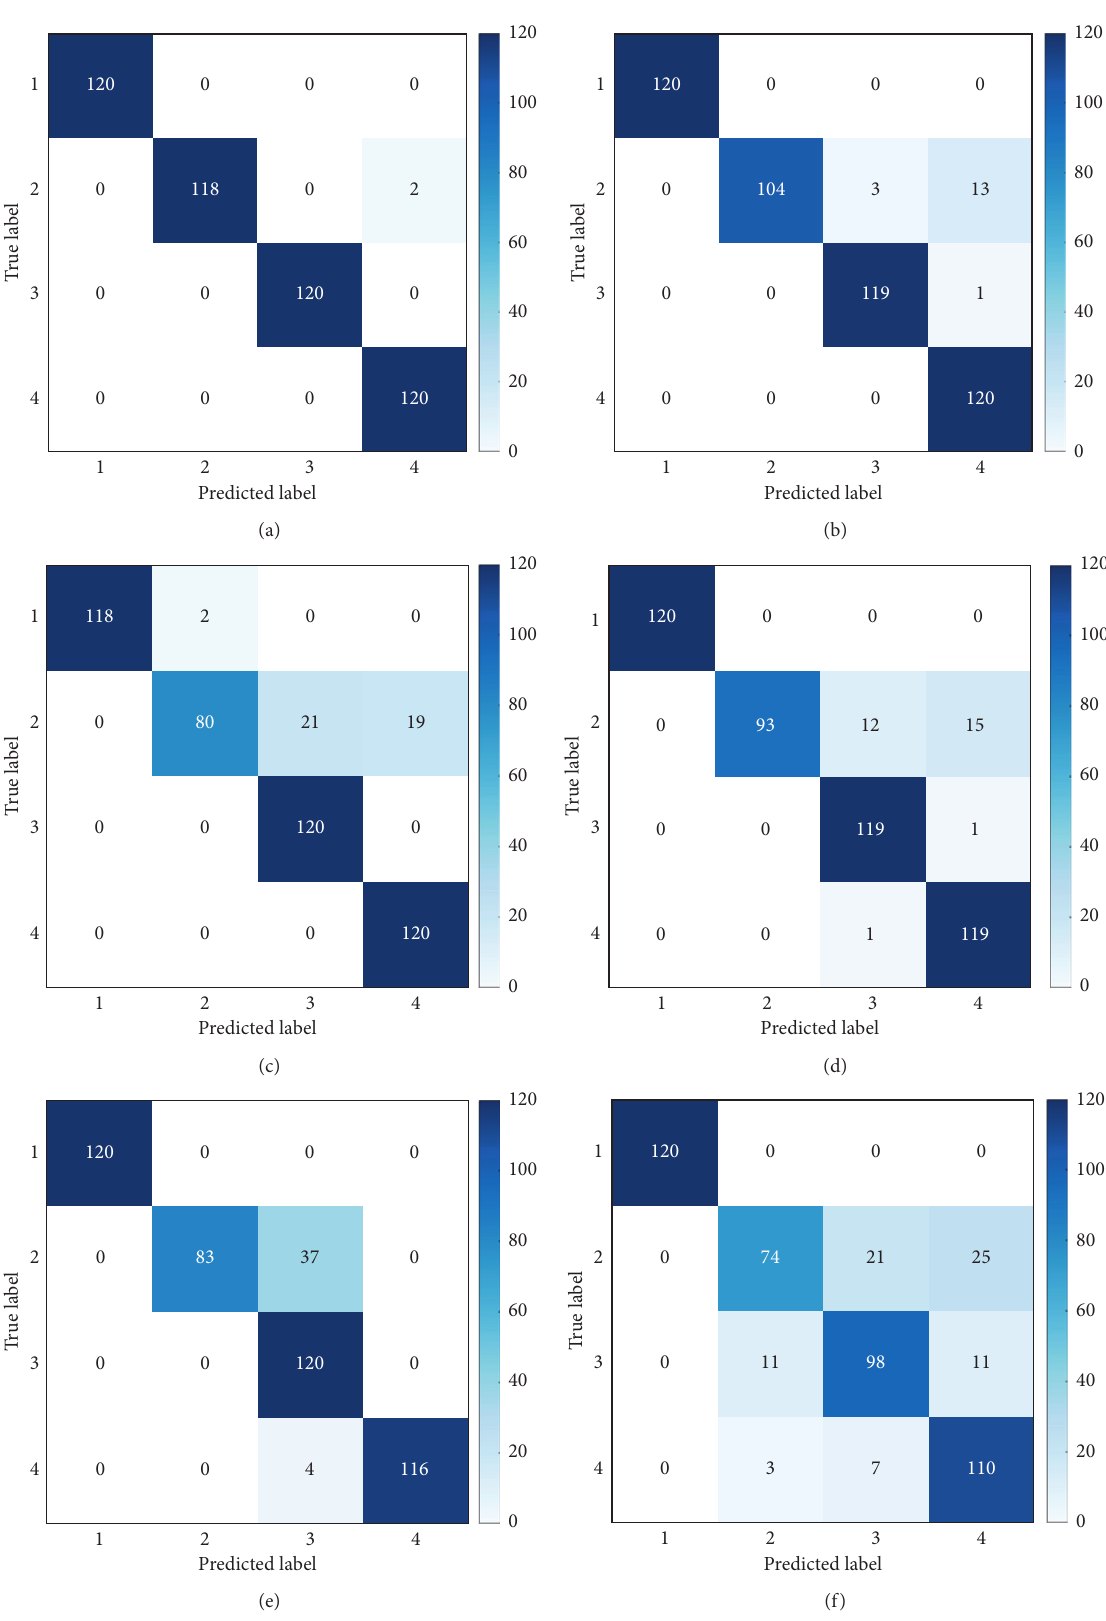
Figure 7: Confusion matrixes using different methods: (a) TDRN; (b) TDCNN; (c) DRN-S; (d) DCNN-S; (e) DRN-T; (f)